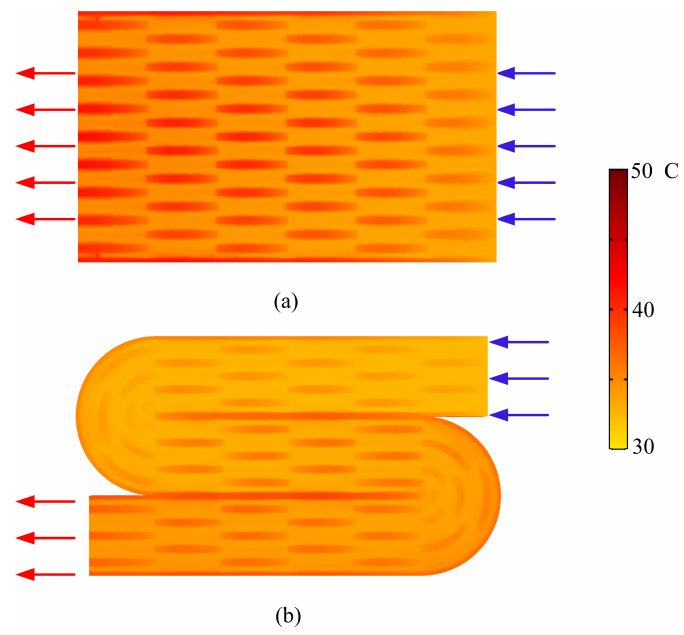
Figure 9. Temperature distribution from heatsink point of view at volumetric flow rate of 18 cm 3 s − 1 in ( a ) Offset strip fin design, ( b ) New offset design.